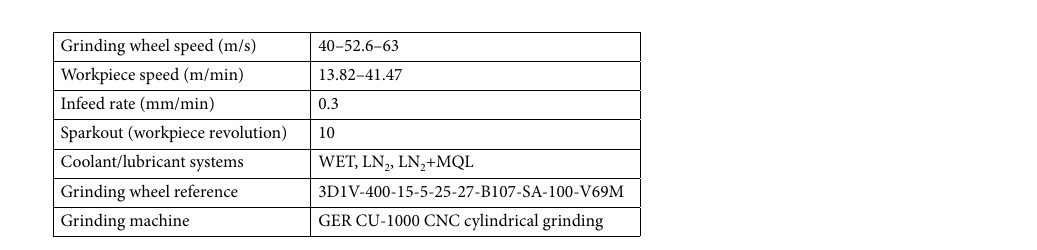
Table 3. Experimental conditions for cylindrical plunge